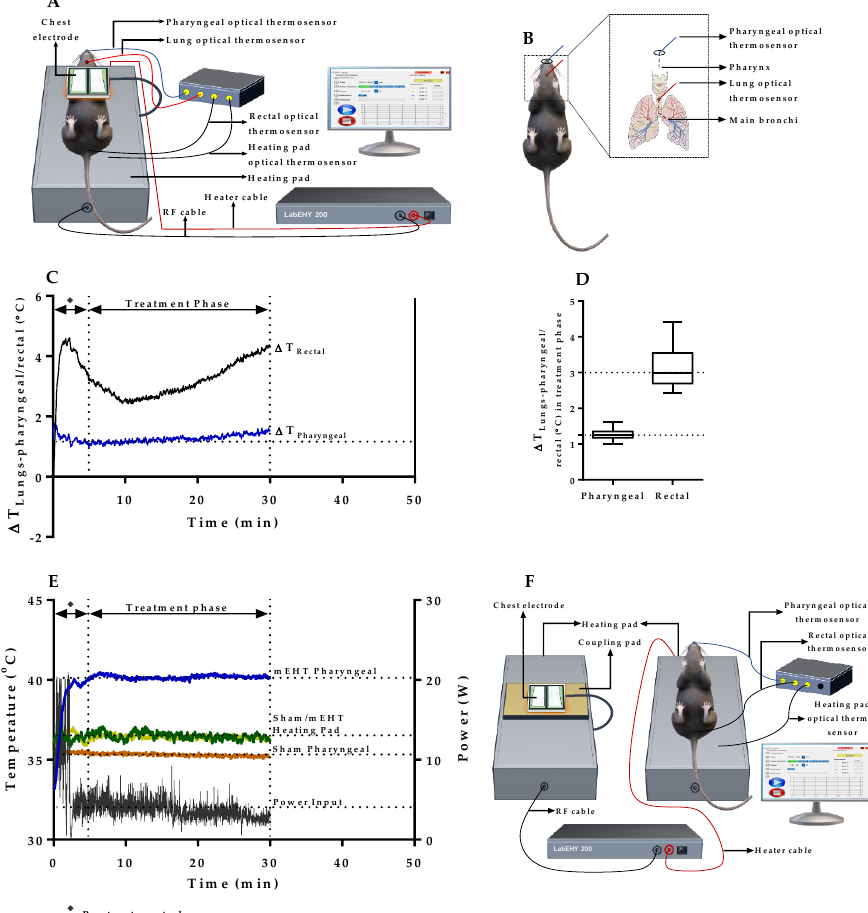
Figure 2. Experimental setup and quantitative relation of lung and pharyngeal temperatures during mEHT treatment of lungs. ( A ) Schematic illustration of the experimental setup of mEHT for lung treatment of mice. The illustration represents setup in pilot experiments for the establishment of quantitative relation between the lung and pharyngeal temperatures with thermosensors positioned in lungs, pharynx, rectum, and heating pad/lower electrode. In subsequent mEHT treatment of tumor-bearing lungs, thermosensors were placed only in pharynx, rectum, and heating pad/lower electrode; ( B ) Schematic illustration depicting placement of pharyngeal and lung optical thermosensors for the establishment of quantitative relation between the lung and pharyngeal temperatures in pilot experiments; ( C ) Temperature gradient between the lung and pharyngeal/rectal temperatures in pilot experiment ( n = 4); ( D ) Plot of the mean difference between lungs and pharyngeal/rectal temperatures in pilot experiment ( n = 4); ( E ) Plot depicting temperature profiles of the pharynx, and heating pad with applied power settings during mEHT treatment of tumor-bearing lungs; ( F ) Schematic illustration of sham treatment setup. Non-distilled, ion-containing water wet coupling pad was used as a coupling material for the emitted radiofrequency signal from the chest electrode. Data represent average ± SEM.